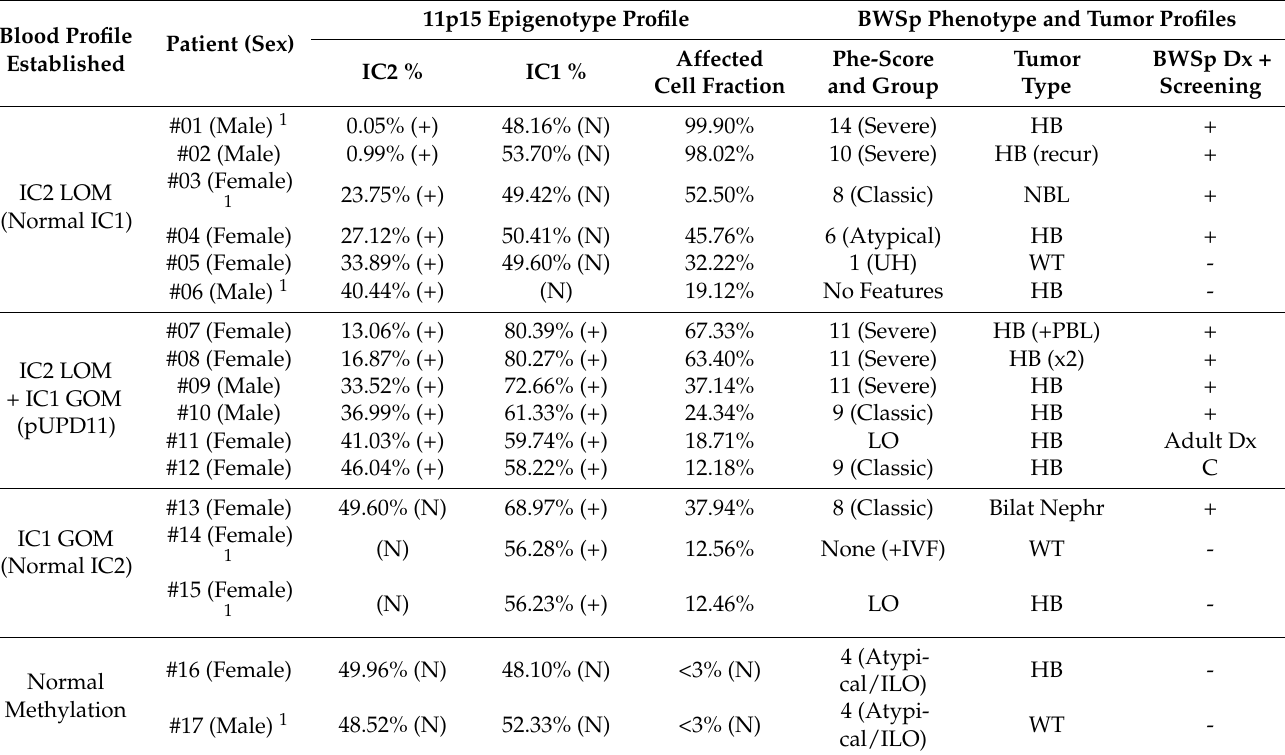
Table 12. Epigenotype profiles (blood) and phenotype patterns associated with tumor development in BWSp. Blood